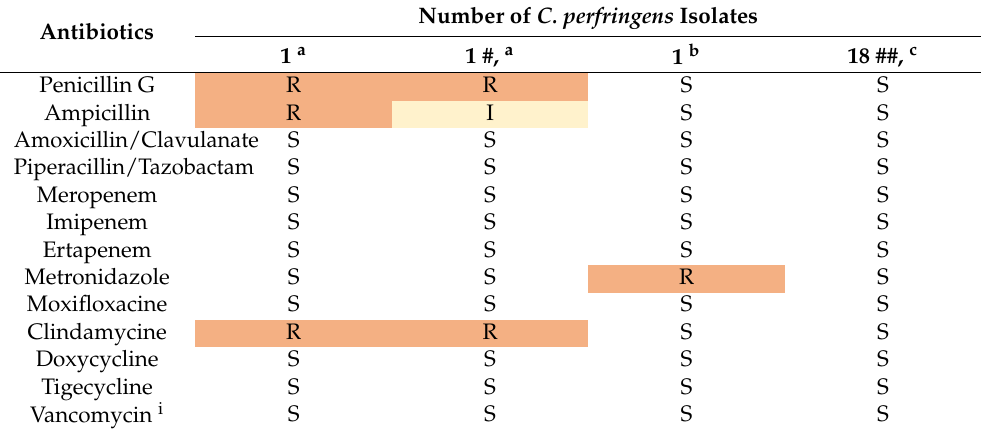
i = here, evaluation was carried out via the breakpoint according to EUCAST (status: January 2021); R = resistant (highlighted in orange), I = intermediate (highlighted in yellow); S = susceptible; # = day 4 p.p., ## = day 4 p.p. ( n = 2) and day 6 p.p. ( n = 3), all other isolates were collected on day 2 p.p.; a = treated with benzylpenicillin procaine, b = treated with benzylpenicillin procaine, tetracycline hydrochloride and penethamathydroiodid (due to additional mastitis), c = 14 isolates from treated cows and 4 isolates from untreated cows, underlined: follow-up isolate from day 2 to day 4 p.p.